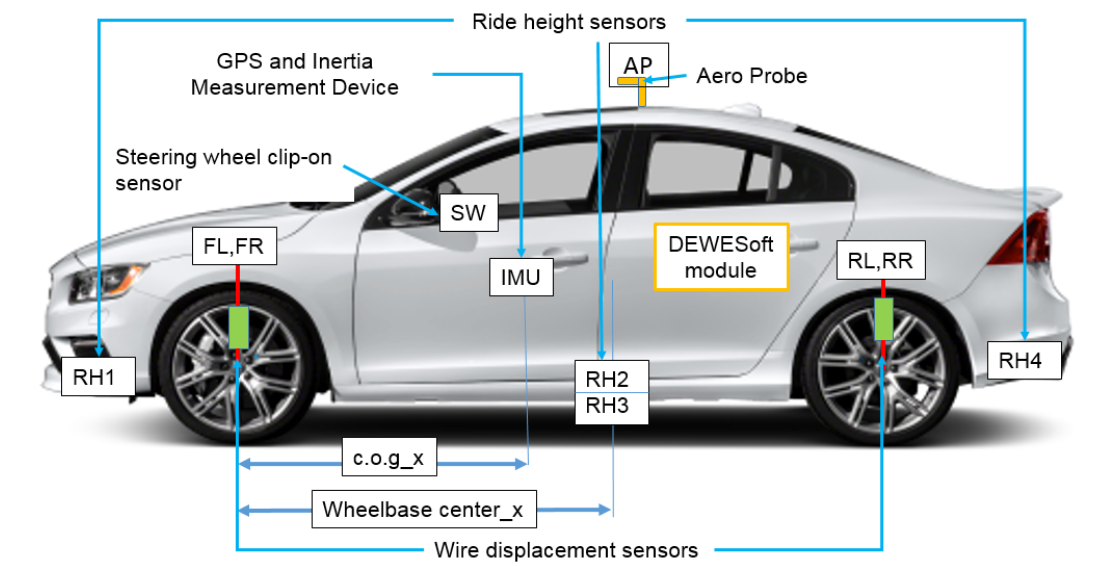
Figure 2. Test Vehicle Instrument